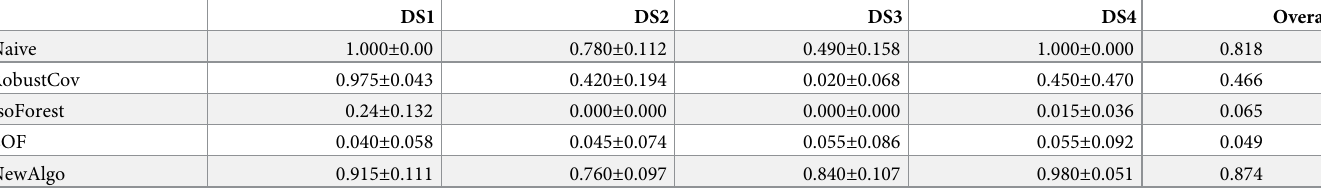
Table 2. The mean and standard deviation TPR for the anomaly detection algorithms. The results represent experiments on four datasets based on 20 simulated experi- ments. The proposed method ( NewAlgo ) produces the best overall results. DS1 Overall Naive